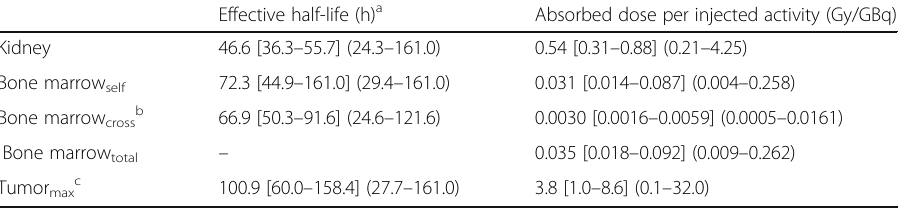
Table 2 Tissue-specific effective half-lives derived from activity concentration at day 1 and day 3, and absorbed doses per injected activity for the 3TP reference method ( n =